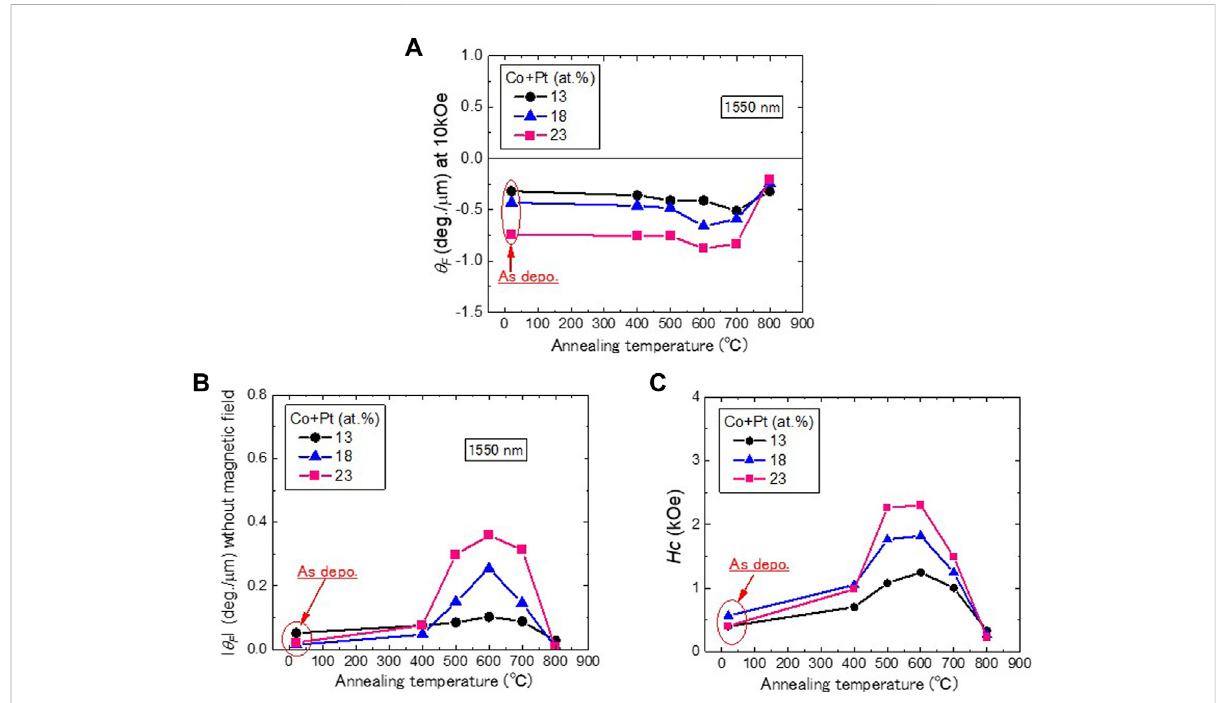
FIGURE 3 Annealing temperature dependence of the magnetic properties in (Co-Pt)-(CaF 2 ) (Co. + Pt = 13,18 and 23 at%) nanogranular fi lms. (A) Relationship between the Faraday rotation angle at 10 kOe and annealing temperature (1,550 nm). (B) Relationship between the Faraday